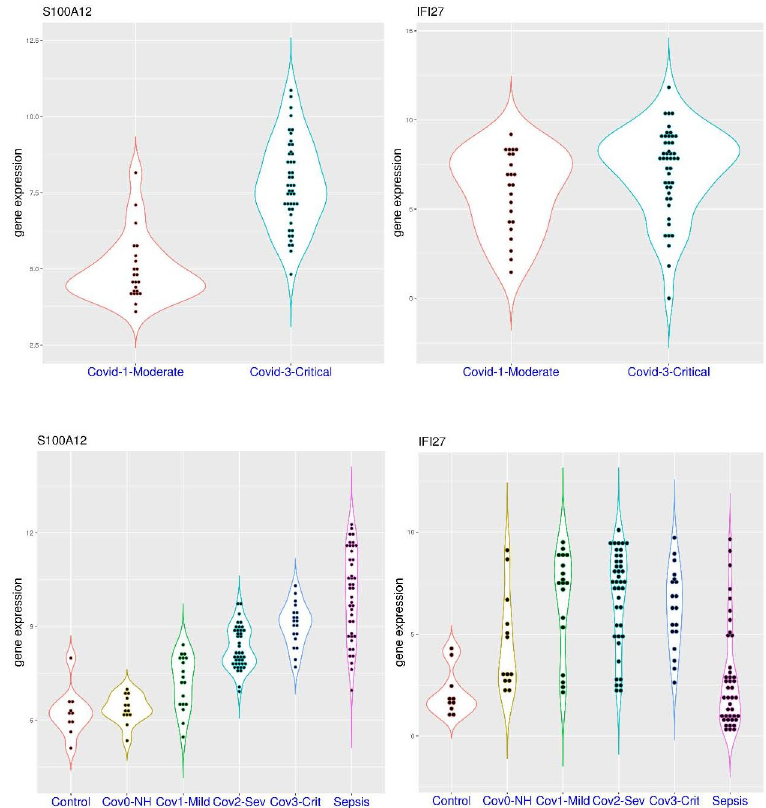
Fig 3. Expression level of S100A12 and IFI27 in COVID-19 patients with different severity (whole blood). A) upper panel (dataset GSE172114), comparison of S100A12 and IFI27 expression in moderate and critical COVID-19 patients. B) lower panel (dataset Zenodo 6120249), comparison of S100A12 and IFI27 expression in COVID-19 patients with different severity (non-hospitalized, moderate, severe and critical).